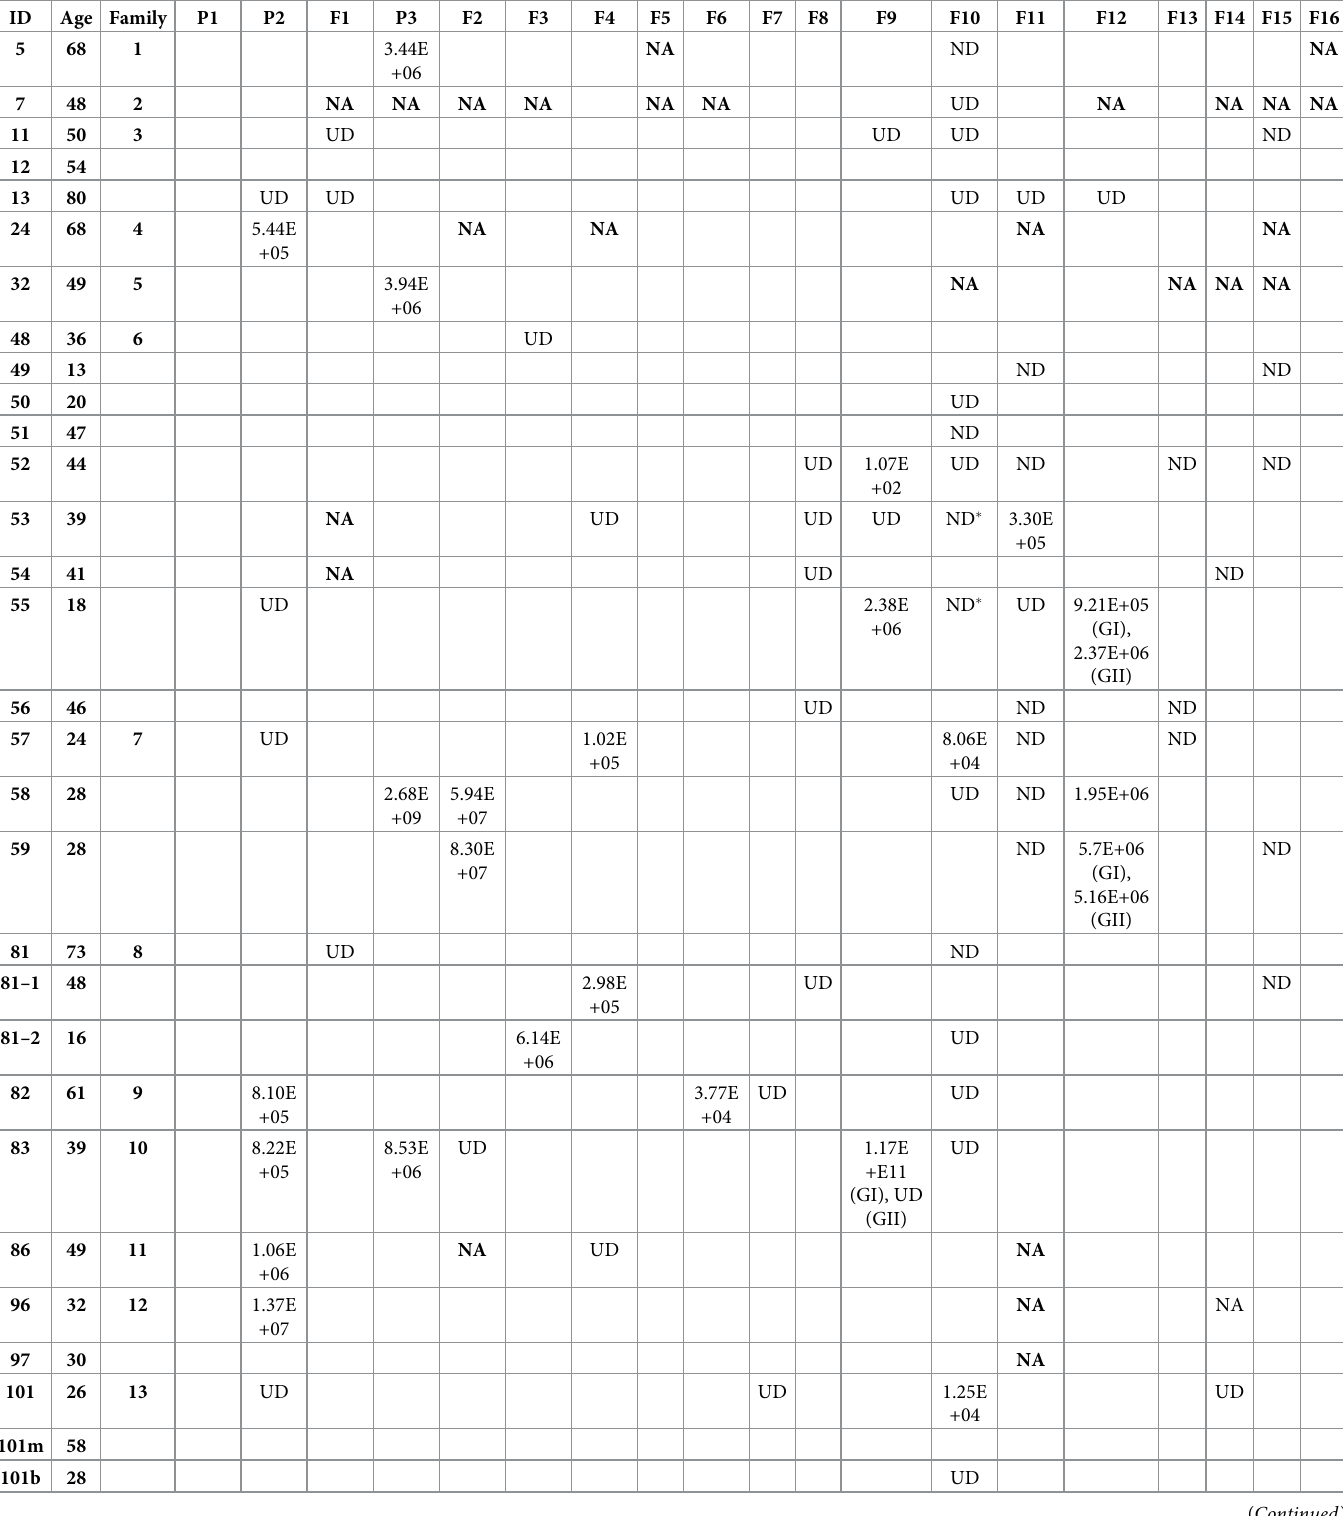
Table 2. Copy number of NV detected in the 1-year